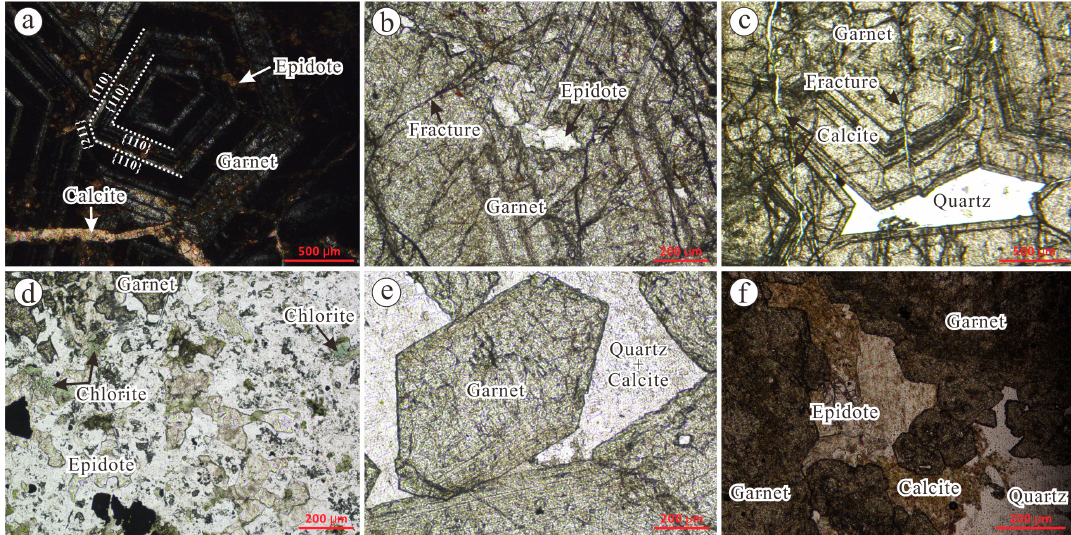
Figure 5. Photomicrographs showing representative textural features of the garnets from the Yongping deposit. ( a ) Dark red garnet particle locally shows a morphological transition from simple dodecahedral {110} growth in the core to composite dodecahedral {110}–trapezohedral {211} growth near its margin in the rim, and it is cut by a calcite vein (CPL); ( b ) dark red garnet particle is locally cut by later fractures and corroded by epidote (PPL); ( c ) green garnet particle has obvious oscillatory zones and is cut by a calcite vein, and the quartz occurring between the garnet particles (PPL) shows an anhedral granular texture; ( d ) green garnet particle with an anhedral granular texture resulted from corrosion by quartz, and the epidote has an anhedral granular texture and is replaced by chlorite (PPL); ( e ) light brown garnet particle with an euhedral granular texture, and calcite and quartz between the garnet particles (PPL); and ( f ) light brown garnet particle with a subhedral granular texture. Epidote, calcite and quartz usually occur between garnet particles, and epidote locally is replaced by calcite (PPL).